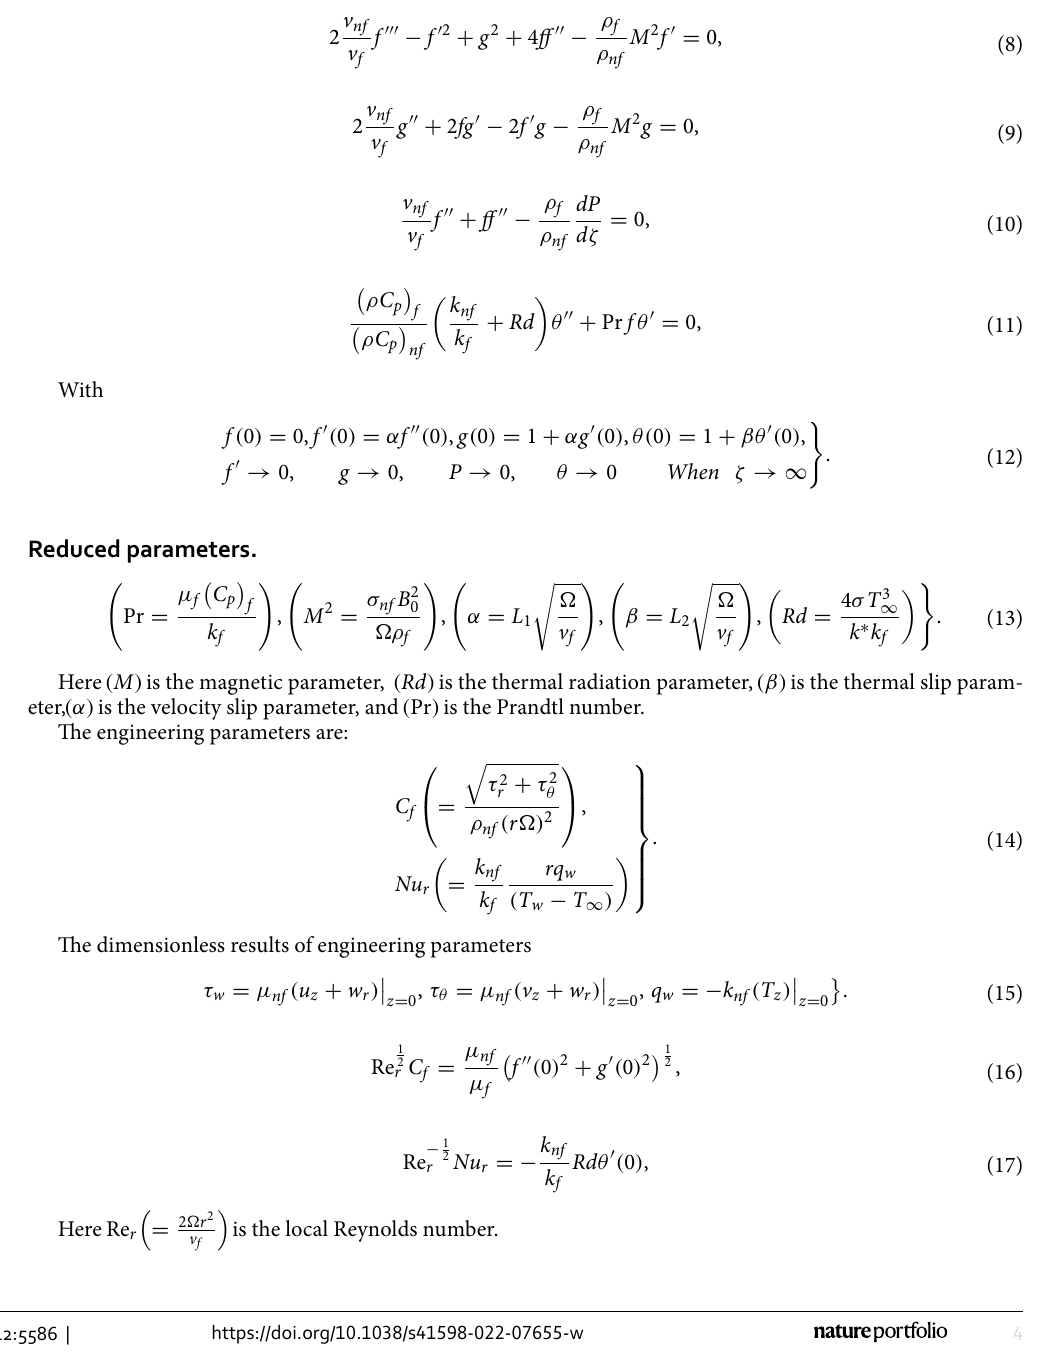
Dimensionless equations. The dimensionless results of the main governing equations